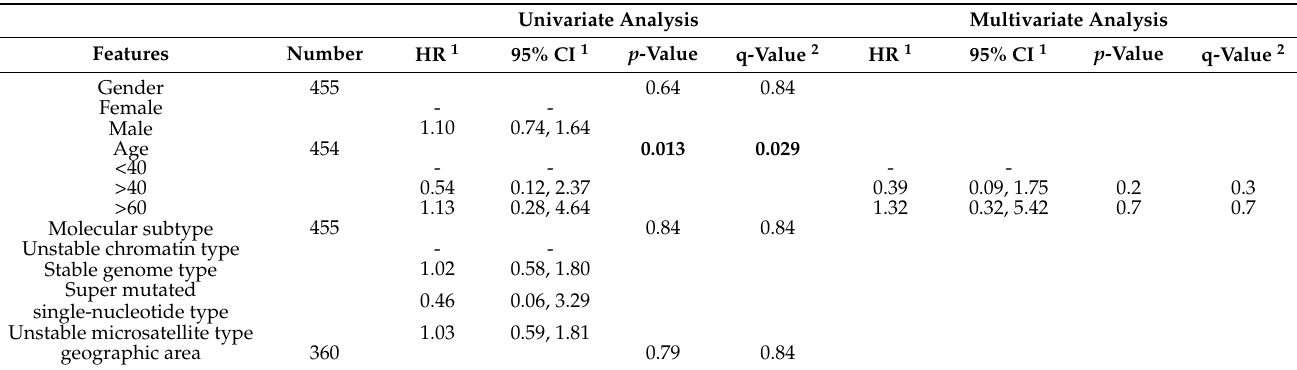
Table 1. Univariable and multivariate analysis of risk factors for